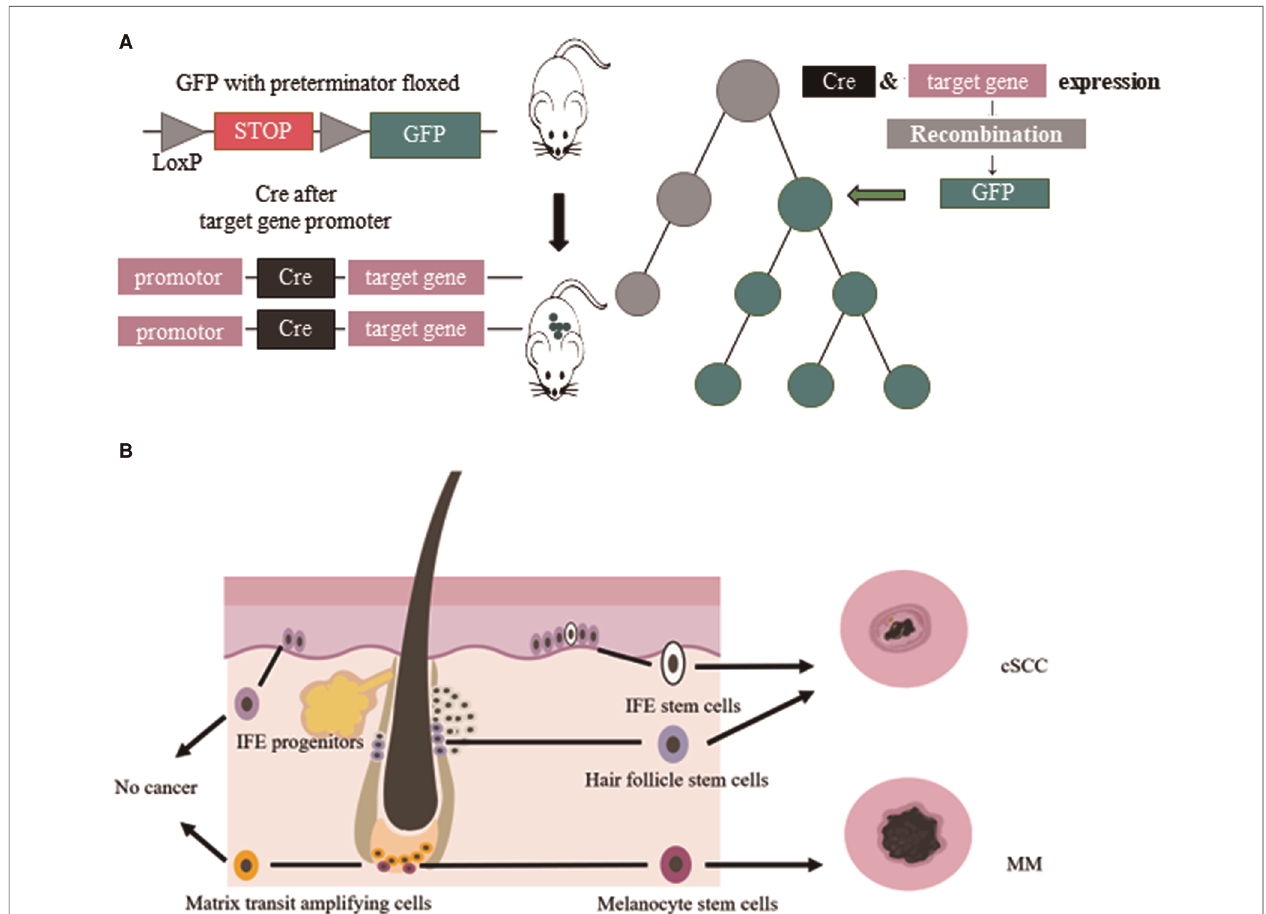
FIGURE 1 | ( A ) Cre/LoxP system for lineage tracing: Transgenic animals with a green fl uorescent protein (GFP) gene preceded by a fl oxed terminator, and a recombinase gene added in front of a gene speci fi cally expressed in the target cell of interest were used. When the cell type begins to show its differentiated characteristics, the recombinase is simultaneously expressed, followed by the expression of GFP. ( B ) Cellular origins of MM and cSCC: IFE stem cells and HFSCs could develop in to cSCC. MCSCs located at the base of hair follicles could develop in to melanoma by external stimulation. Other cells, such ad IFE progenitors, do not become